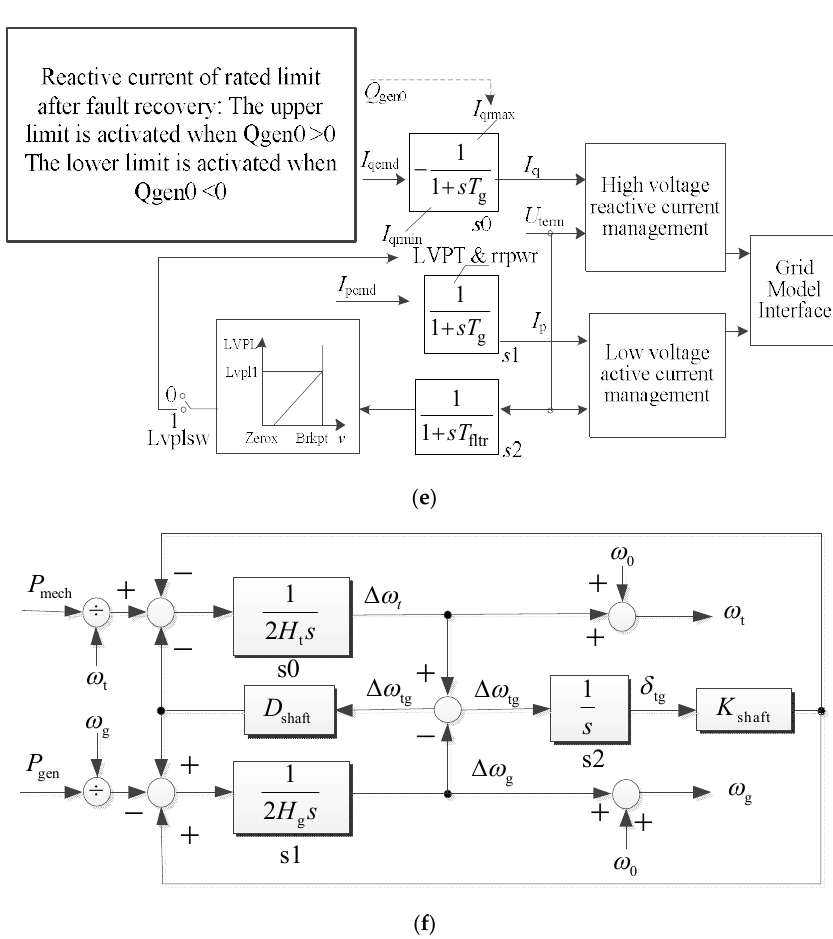
Figure 1. Second-generation generic model (GM) of Type 4 wind turbine generators (WTGs): ( a ) Type 4A; ( b ) Type 4B; ( c ) repc_a; ( d ) reec_a; ( e ) regc_a; ( f )